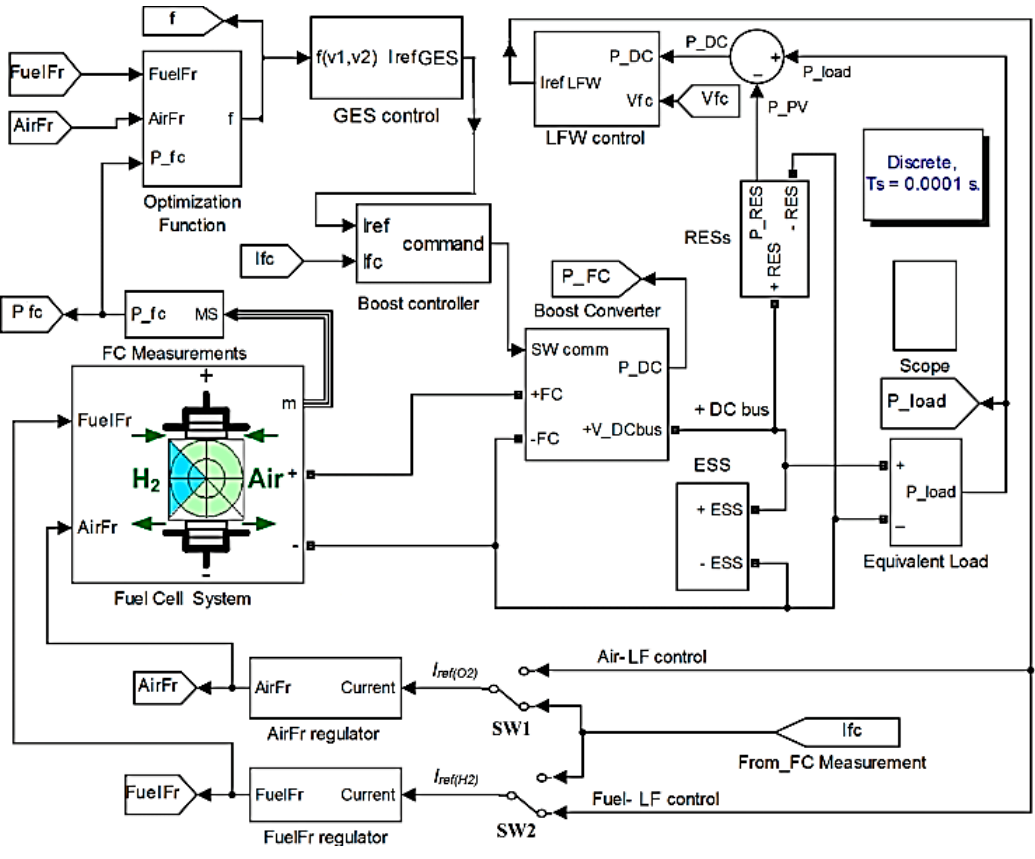
Figure 1. The RES/FC HPS topology. Figure 1. The RES / FC HPS